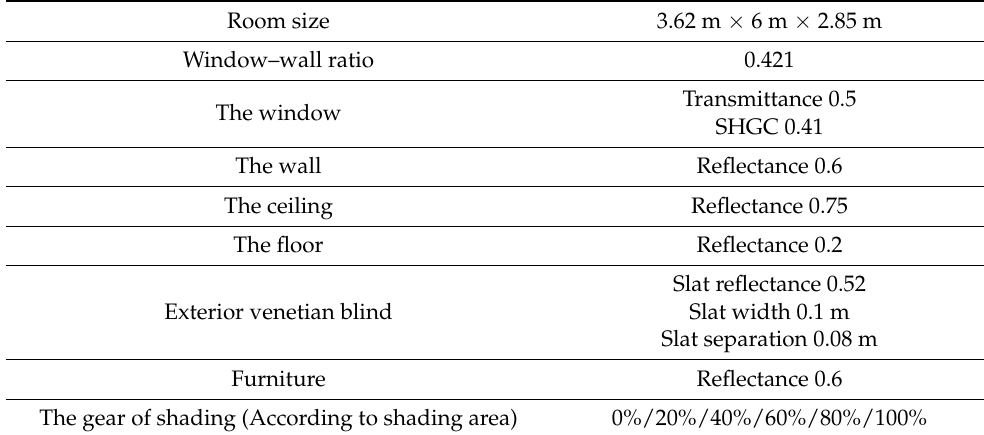
Figure 7. Layout of case 2 room. Table 5. Summary of room parameters in case